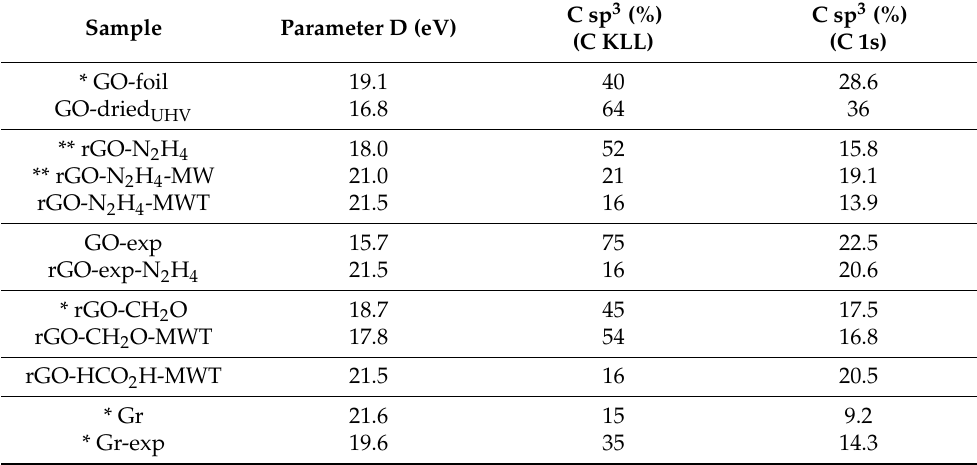
Table 4. Values of parameter D determined from the first derivative of C KLL AES spectra, C sp 3 percent resulting from parameter D and fitting of C 1s spectra. Evaluation of C sp 3 from C KLL spectra was performed using a calibration curve and parameter D for standards of 13.2 eV (C sp 3 ) and 23.1 eV (C sp 2 )